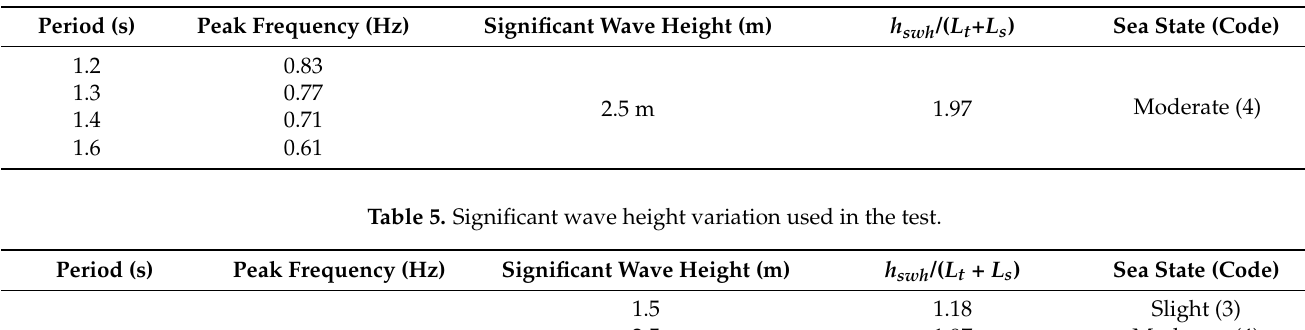
Table 4. Peak frequency variation used in the test.